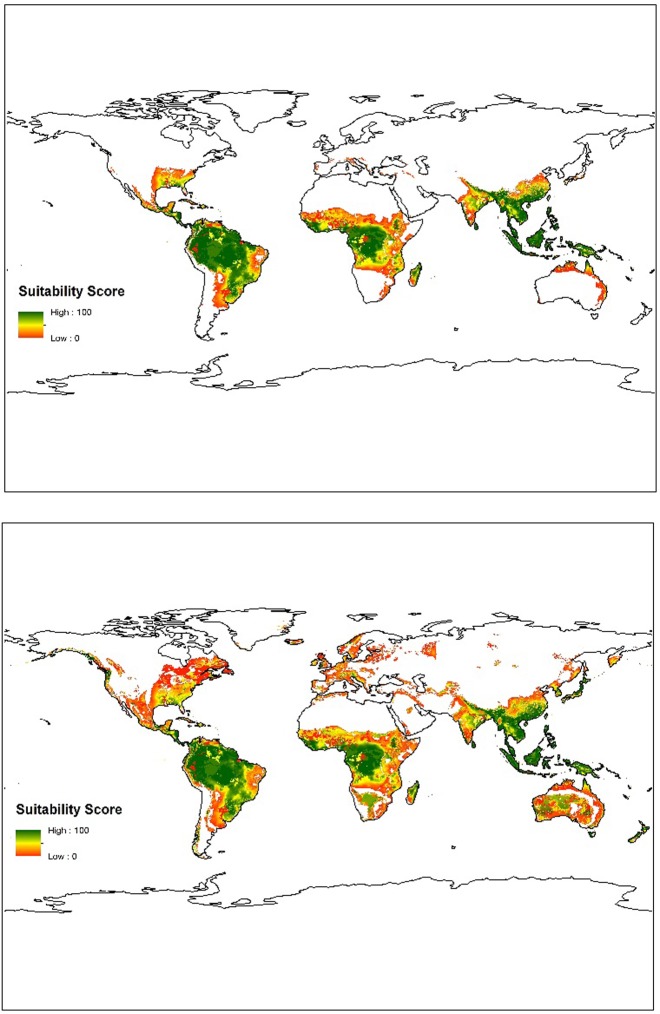
Modeled future global suitability in 2070 for RCP 4.5 (top) and RCP 8.5 (bottom).